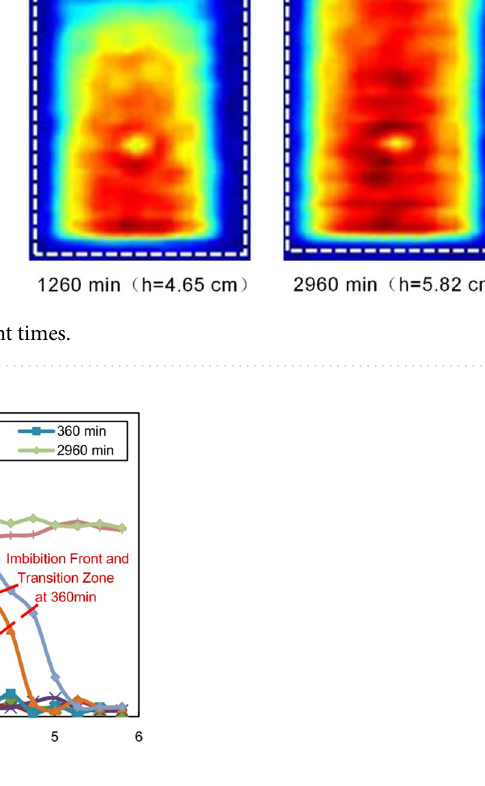
Figure 5. Distribution of water saturation at different